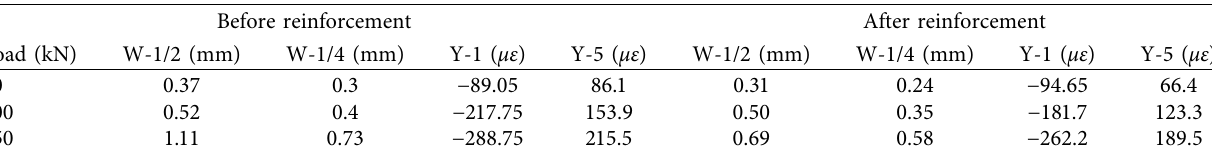
Table 10: The comparison of strain and deflection (before and after bonded steel reinforcement) under different load. Before reinforcement After reinforcement Load (kN)